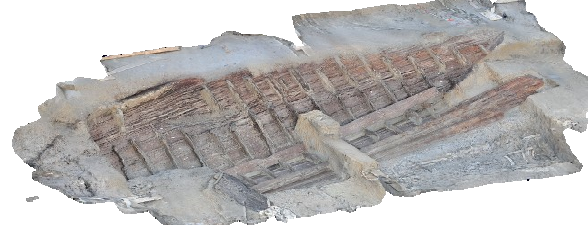
Figure 5. Multi-image photogrammetric model of the boat in 2014.